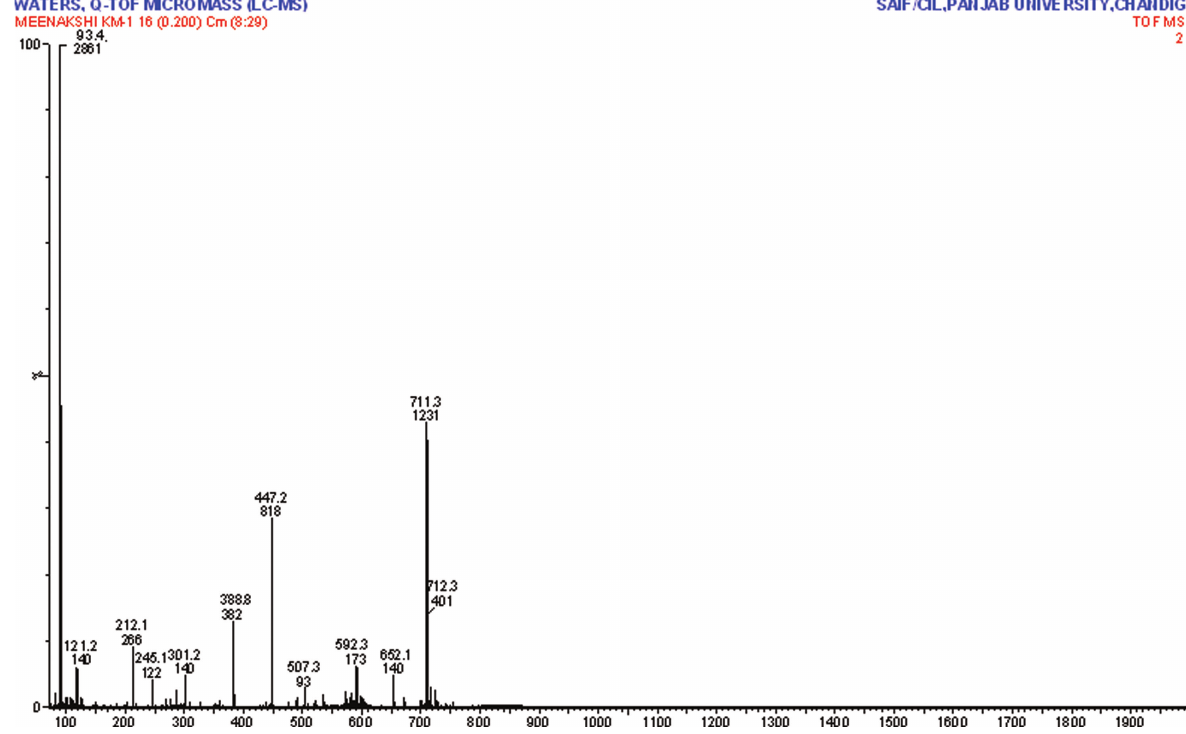
Figure 2: Q-TOF(LC-MS) spectrum of complex [( μ -OPr i )